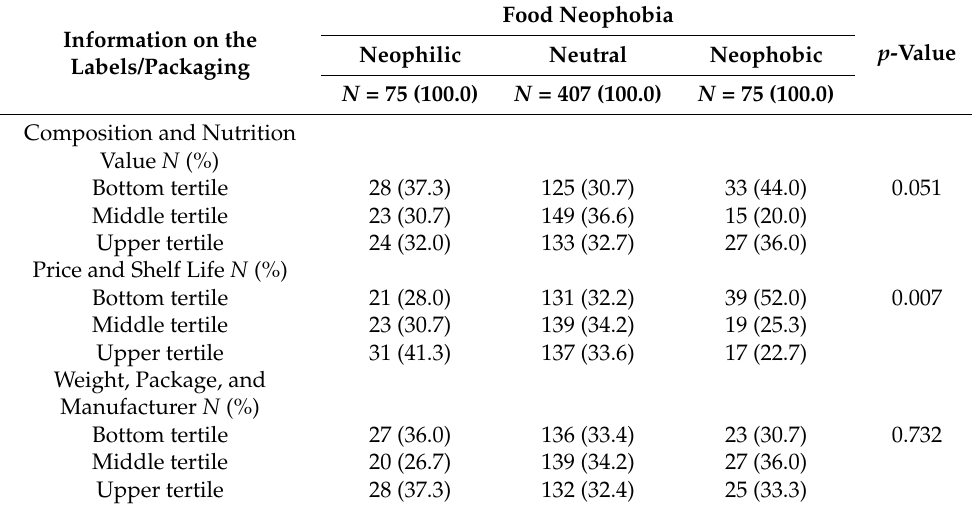
Table 6. Associations between food neophobia and reading food labels ( N = 557). Information on